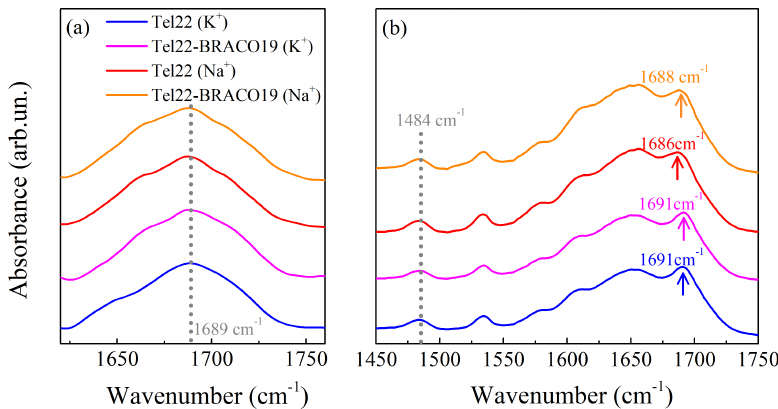
Figure 2. ( a ) Diffuse Reflectance Infrared Fourier Transform (DRIFT) spectra of of Tel22 (K + ), Tel22 (Na + ), Tel22-BRACO19 (K + ), and Tel22-BRACO19 (Na + ) in the C6O6 carbonyl stretching vibrational peak region, highlighted with dotted line. ( b ) Attenuated Total Reflectance-Fourier Transform Infrared (ATR-FTIR) spectra of the same four samples in the [1450–1750] cm − 1 spectral region. The arrows indicate the peak center for each spectrum. The dotted line represents the G-quadruplex (G4) characteristic